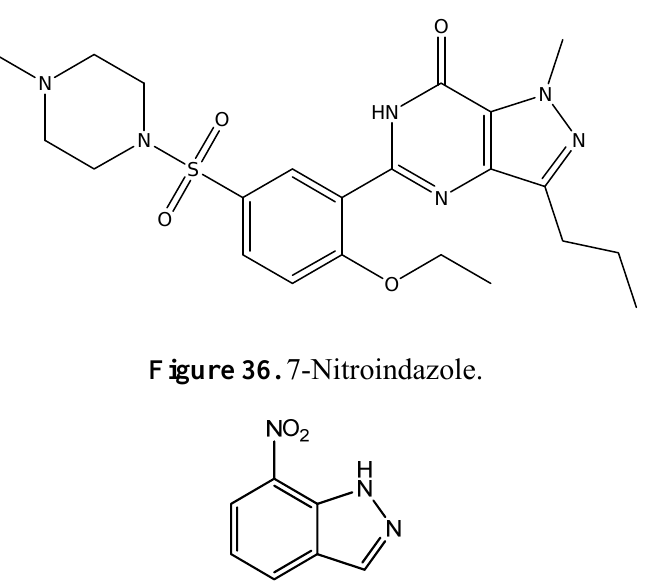
Figure 35. Sildenafil.